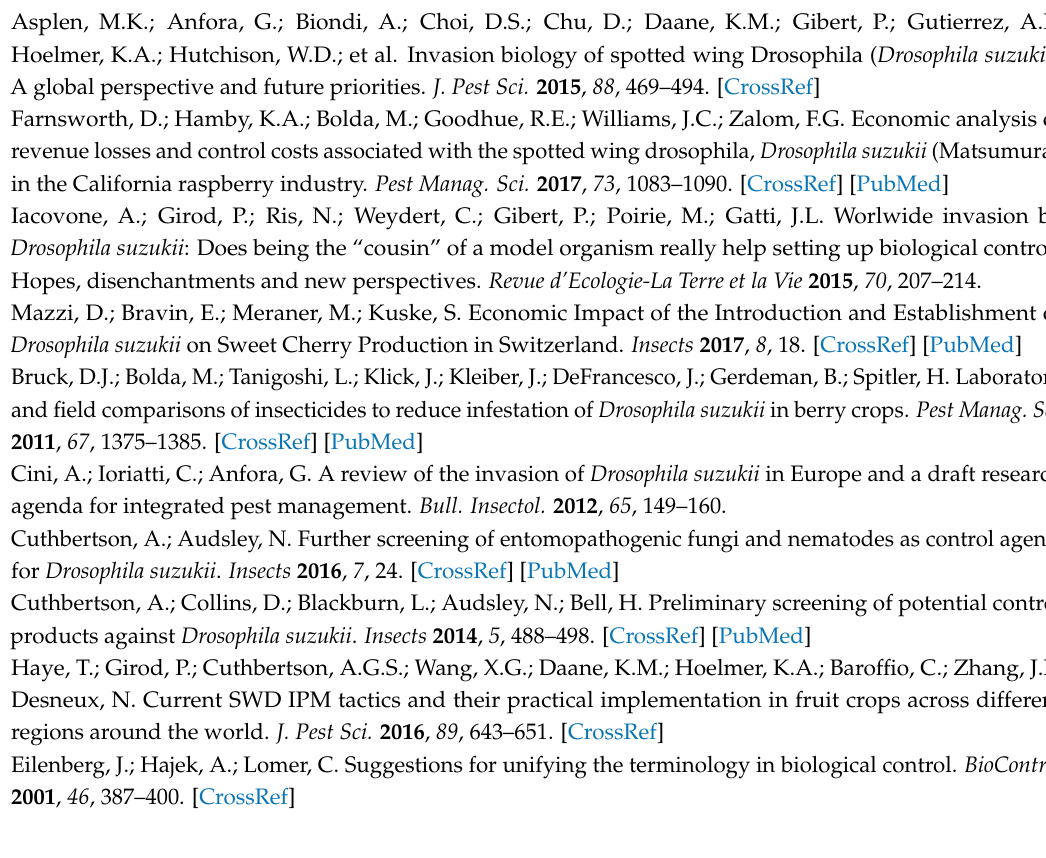
Figure S1: Localization of the sampling sites on the satellite map. Sampling sites are indicated by color dots on the satellite picture of the Alpes-Maritimes area (from the geoportal, IGN) visualizing their geographical position (Valley, mountainous backlands and distance to the seaside). The large yellowish dot indicates the town of Nice. The position of the Alpes-Maritimes on the France map is indicated in the insert. Table S1: Climatic data related to the investigated area. These four references were chosen for their vicinity to one or two of the sampled locations (see Table 1). MTmin/MTmea/MTmax respectively indicate the monthly means of daily minimal/mean/maximal temperatures while MRH indicates the monthly Mean Relative humidity. Sampling dates are indicated in the “Session” column. Table S2: Summary of post hoc tests (Tukey HSD tests) dealing with the temporal abundances of the three most abundant parasitoids. When the comparison between two sampling dates (S1 to S7—see Material and Methods) was possible, we indicate the observed statistics (above) and the related p -value